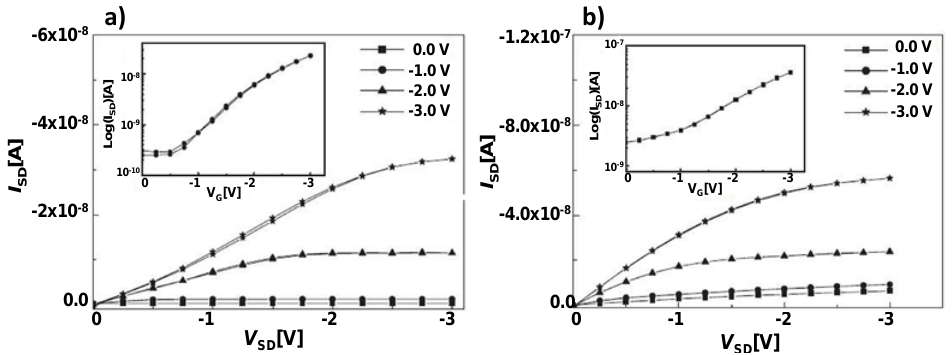
Figure 4. Output curves of PTA-OMe OFETs: ( a ) before NO 2 exposure; and ( b ) after NO 2 exposure. The insets show saturated transfer curves of the corresponding OFETs in semilog plots. Reprinted with permission from Ref. [28]. Copyright (2007) Wiley-VCH.